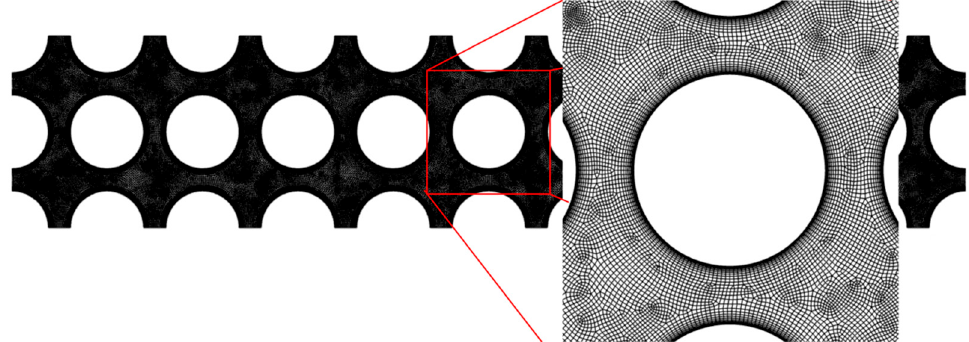
Figure 5. The mesh of the computational domain.